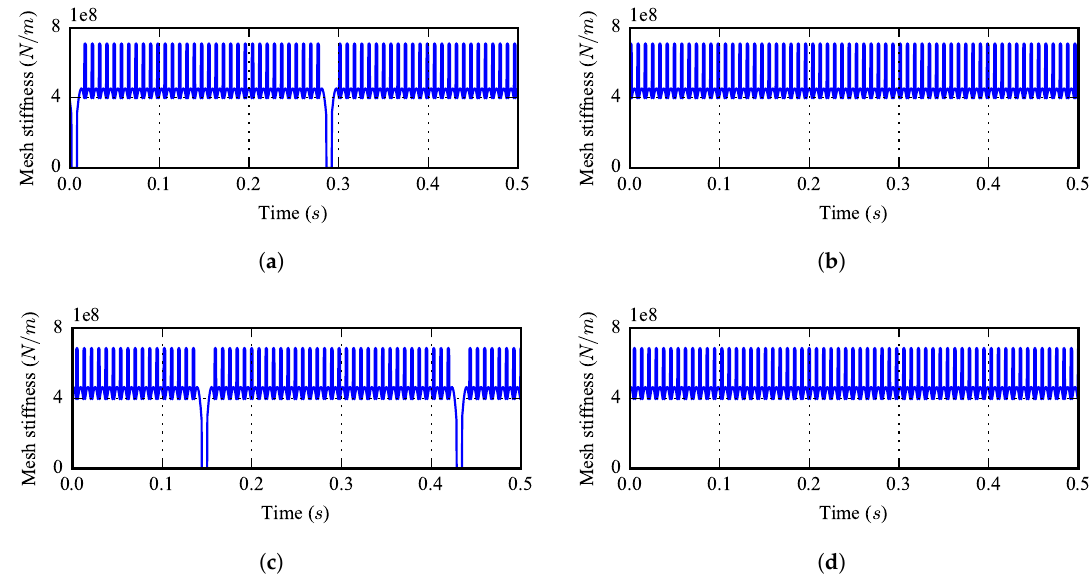
Figure 3. The time-varying mesh stiffness in a planetary gear: ( a ) sun-first planet, ( b ) sun-second planet, ( c ) ring-first planet and ( d ) ring-second planet.